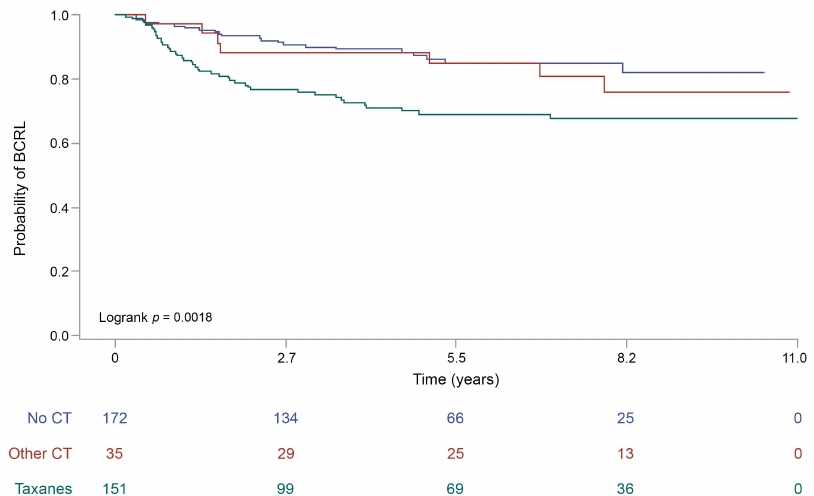
Figure 1. Lymphedema-free survival of the patients included in the study according to the type of chemotherapy. The curves are built according to the by Kaplan-Meier method, p values are the expression of Log-rank test. The specific risk for a given timeframe is reported on the bottom of each graph. BCRL, breast cancer related lymphedema; CT,